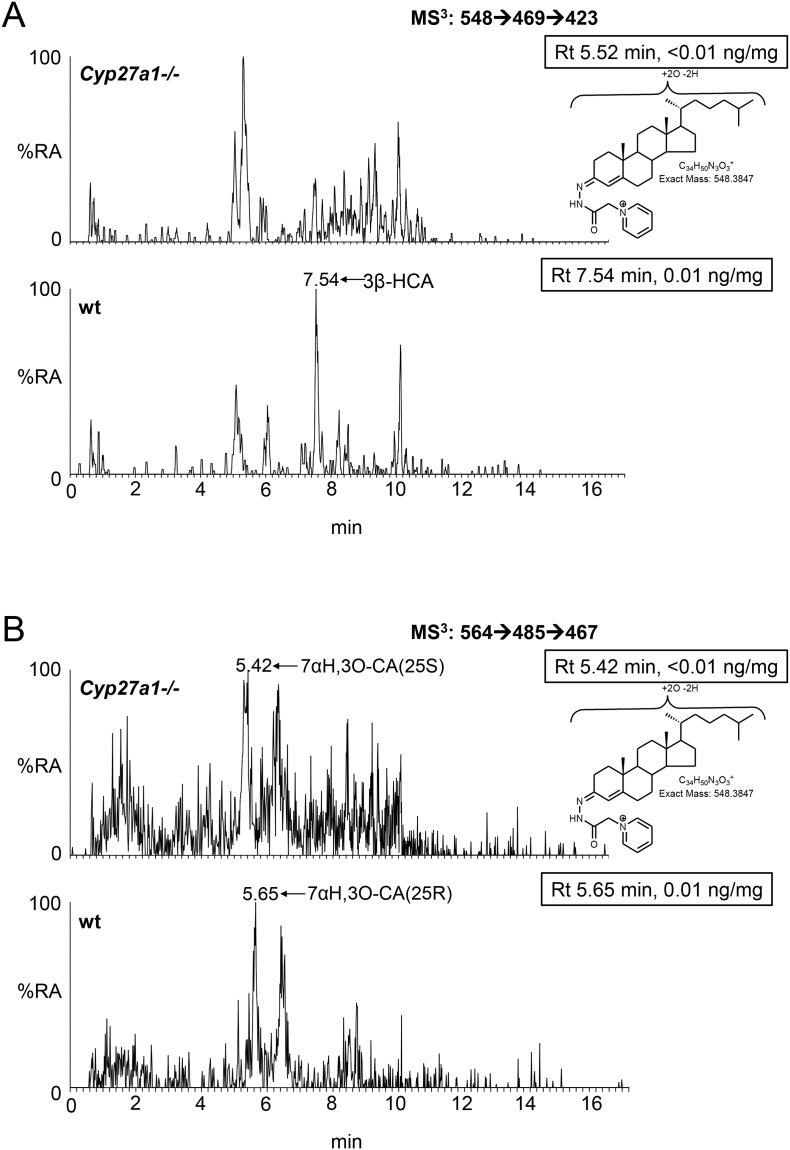
Cholestenoic acids in Cyp27a1−/− and Cyp27a1+/+ (wt) mouse brain. Each chromatogram is normalised to the most intense peak at 100% RA. Magnification factors are as indicated. The concentration of the indicated analyte (by Rt) is given in the right-hand corner of each chromatogram. Chromatograms from the oxysterol fractions treated with cholesterol oxidase (combination of sterols with a native 3-oxo group and those oxidised by cholesterol oxidase to contain a 3-oxo group) are shown. The insets show structures of generic GP derivatives. Many cholestenoic acids elute as twin peaks corresponding to syn and anti conformers. (A) 3β-Hydroxychest-5-enoic and 3-oxocholest-4-enoic acids, and dihydroxycholestenones and hydroxycholestenediones. (B) Dihydroxycholestenoic and hydroxyoxocholestenoic acids. Abbreviations: 3β-HCA, 3β-hydroxycholest-5-en-(25R)26-oic; 7αH,3O-CA(25R or S), 7α-hydroxy-3-oxocholest-4-en-(25R or S)26-oic.